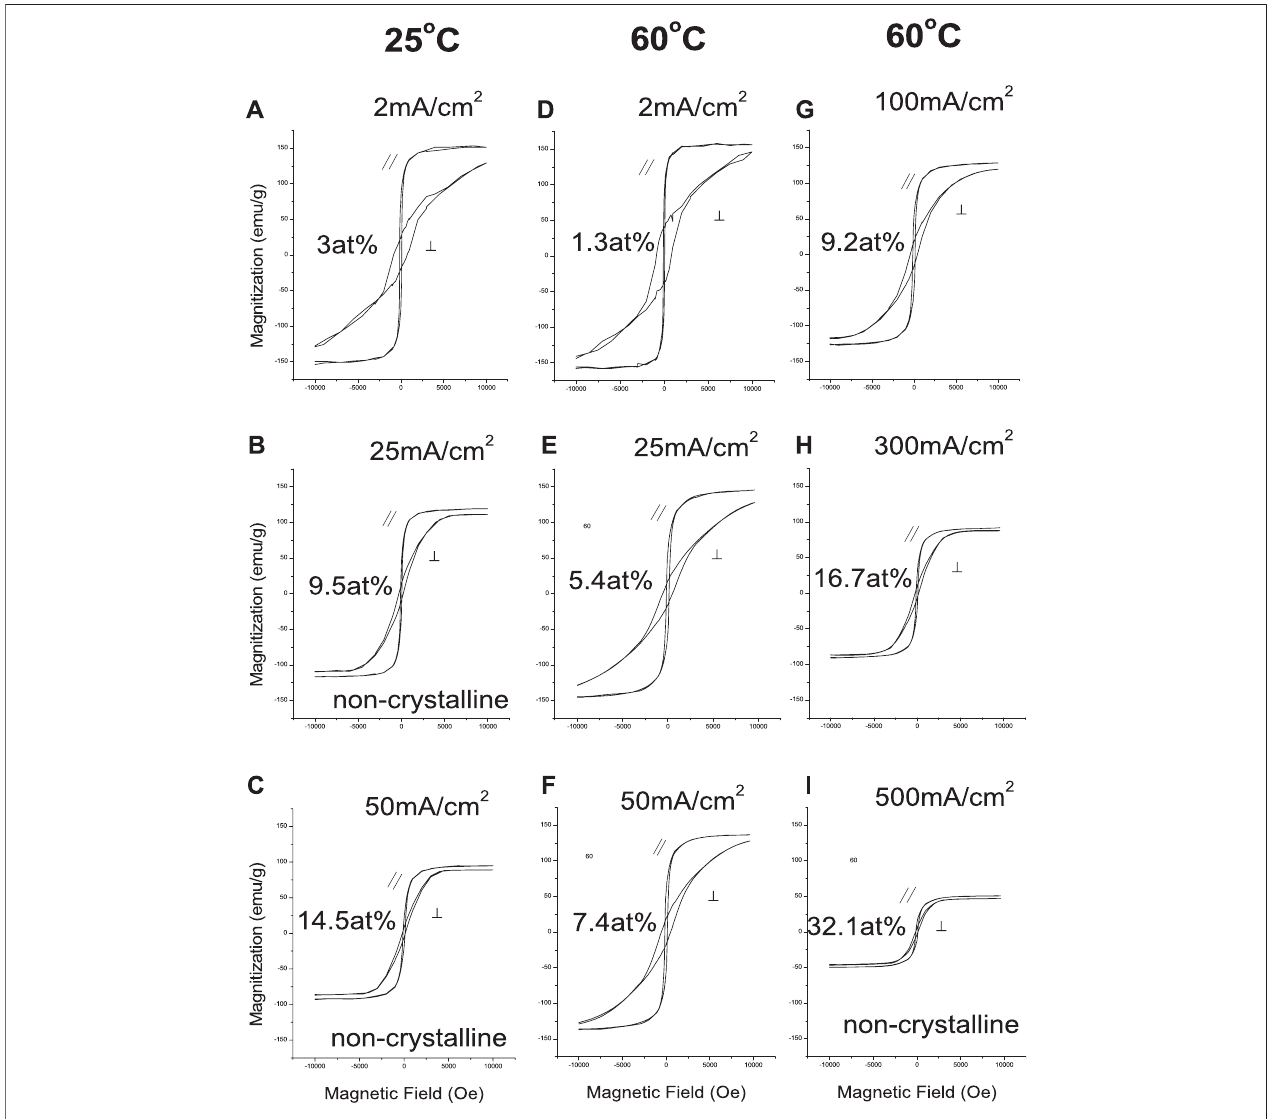
FIGURE 5 | Magnetic hysteresis loops of Sm-Co deposits at 25 and 60 ° C, and various CDs.